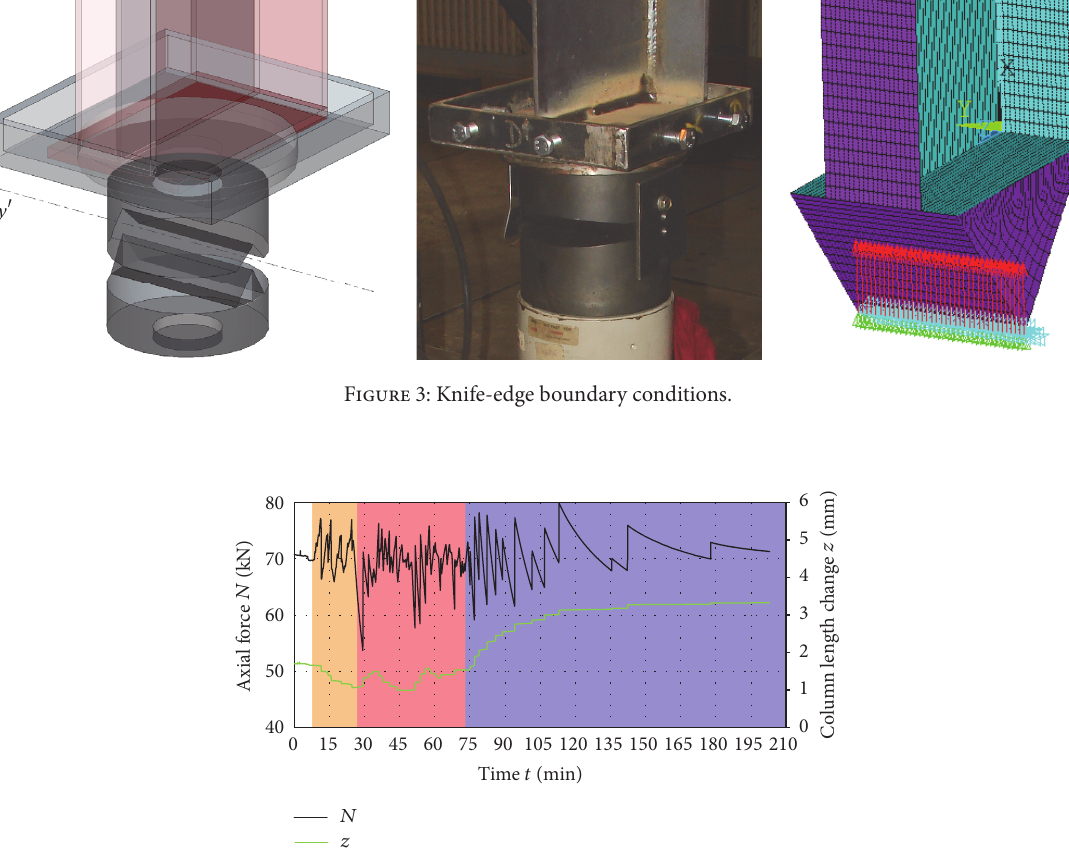
Figure 4: Axial force and column length changes during the spot welding (orange background colour), welding process (red colour), and cooling (blue